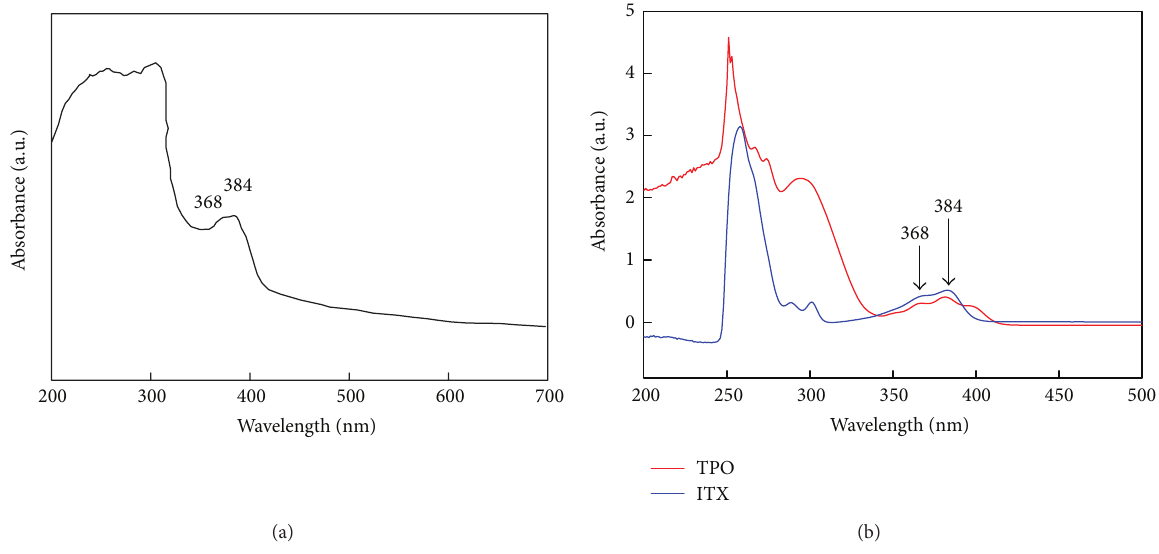
Figure 4: Absorption spectra of (a) microcapsules and (b) photoinitiators TPO and ITX.